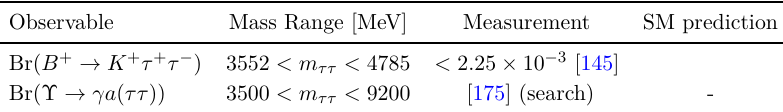
< 11 . 0 GeV 2 and 12 . 5 < m 2 < µµ µµ decays peak around the ( s )